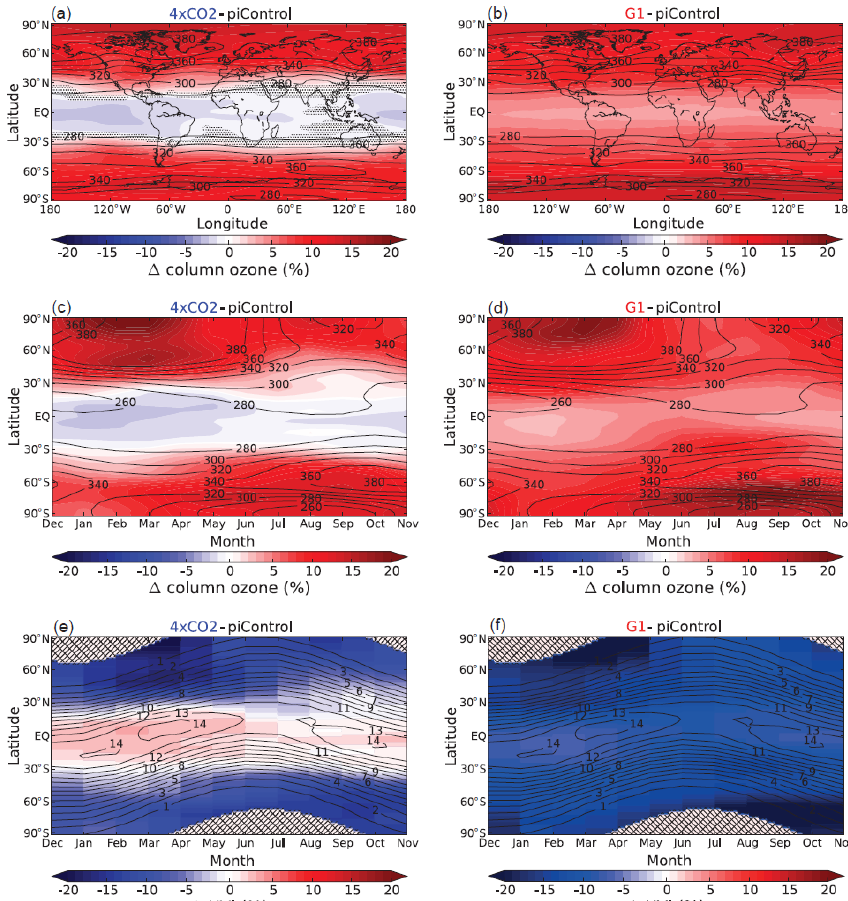
Figure 4. Column ozone differences and their impact on the UV index. Relative to piControl: left for 4 × CO 2 , right for G1. Top row panels: annual mean (cid:49) column ozone (colours, %). Non-significant changes (using a two-tailed Student’s t test at the 95% confidence level) are marked by stippling. Middle row panels: seasonal cycle of the column ozone changes as longitudinal and monthly means. Bottom row panels: seasonal cycle of the column ozone induced changes in the UV index, and in (f) additionally by the solar constant reduction, at noon. Polar night regions in (e, f) are crossed out; both daily (solar declination) and monthly changes (ozone) are considered, giving rise to a less smooth appearance. Contour lines show pre-industrial column ozone in Dobson Units (DU) in the upper two rows and pre-industrial UV indices in the last